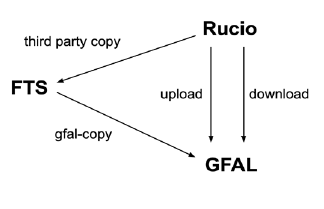
Figure 1: The Data Lake transfer